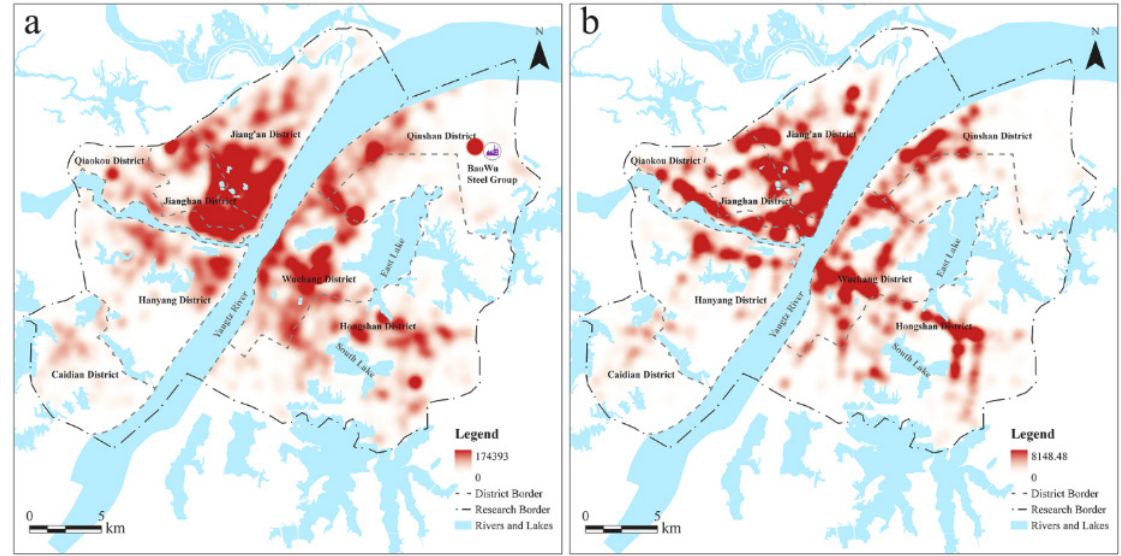
Figure 3. KDE maps of the demand and supply of bus services. ( a ) Demand; ( b )